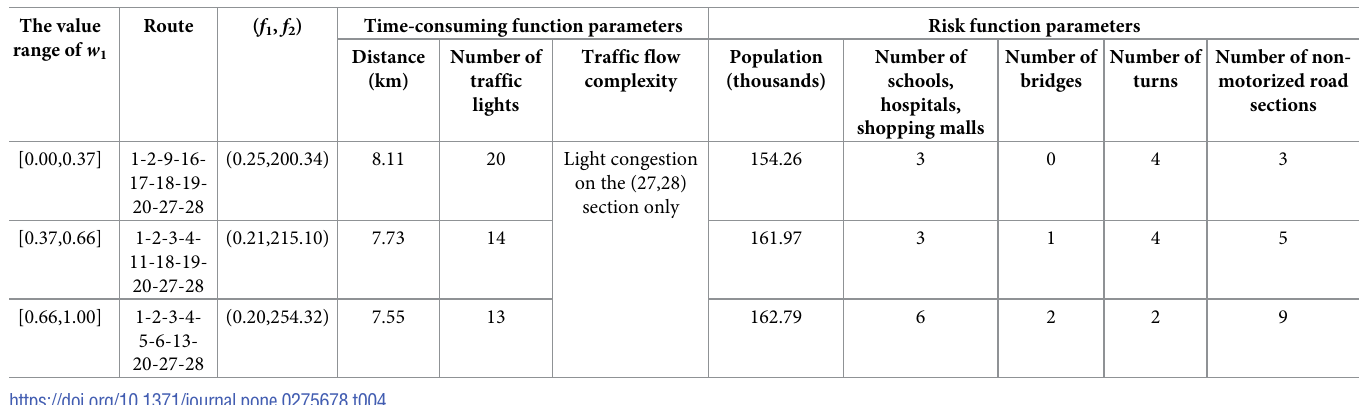
Table 4. Summary of routes